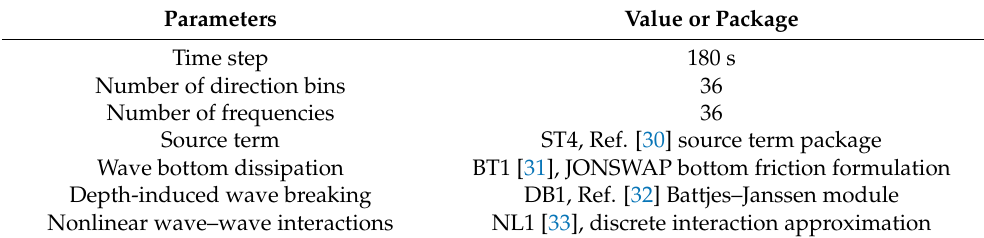
Table 2. Con fi guration of model parameters for the WW3 model in the present study. Table 2. Configuration of model parameters for the WW3 model in the present study.